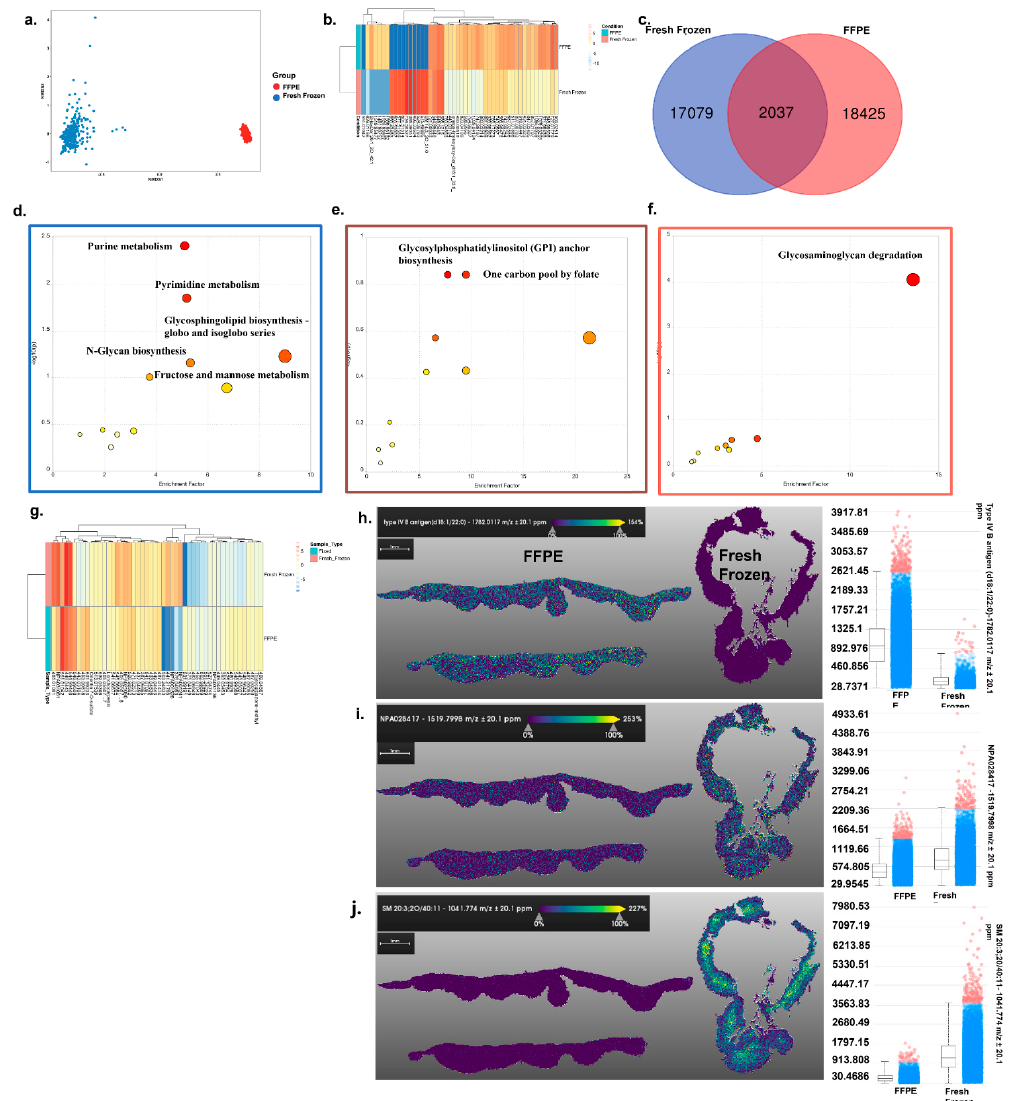
Figure 1. MALDI positive mode imaging of skin tissue: ( a ) Nonmetric dimensional plot of the metabolites present in fresh frozen and FFPE samples. An ANOSIM test showed that there are significant differences in the metabolic profiles of the groups tested. (Stress: 0.03219174, ANOSIM statistic R: 1, significance: 1 × 10 − 4 ). ( b ) Heatmap plot of the top 50 most significantly different metabolites between the two groups. ( c ) Venn diagram showing the unique and shared metabolites from the two groups. ( d – f ) Metabolic pathway analysis plot created using MetaboAnalyst 5.0, USA. Plots depict several metabolic pathways that differ between the fresh frozen and FFPE samples tested. ( d ) Differential metabolites calculated from FFPE vs. fresh frozen samples. ( e ) Common metabolites from the FFPE and fresh frozen groups were sorted based on p -values (high to low). ( f ) Differential metabolites were calculated from fresh frozen vs. FFPE. (Box color corresponds to the same color from the Venn diagram). The y -axis is the log scale of the p -value; pathways that were most significantly different are characterized by high –log10( p ) values. ( g ) The top 50 common metabolites were sorted based on p -value and are represented as a heatmap with their detected intensities. ( h – j ) Specific metabolite distribution images are presented along with an intensity box plot. ( h ) An image of type IV B antigen distribution in both tissues and an intensity box plot of the same metabolite’s distribution. ( i ) An image of NPA028417 distribution in both tissues and an intensity box plot of the same metabolite’s distribution. ( j ) An image of SM 20:3: 20/40 distribution in both tissues and an intensity box plot of the same metabolite’s